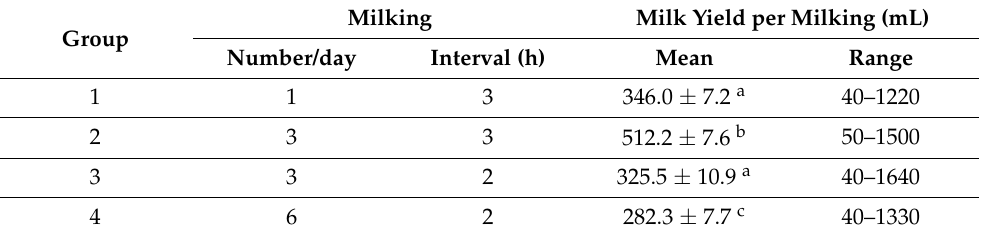
Figure 3. Donkey mare during machine milking at a Jordanian donkey farm [30]. Table 7. Effects of daily milking number and interval between milkings on milk yield per milking in donkey mares